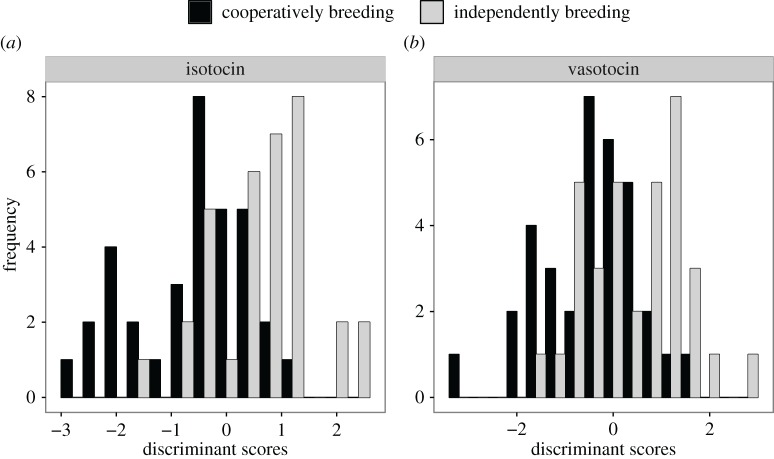
Discriminant function scores for (a) isotocin neuronal phenotypes and (b) vasotocin neuronal phenotypes. Individual fish were significantly classified into their cross-validated social system using their isotocin (p < 0.05) but not their vasotocin neuronal phenotype (p > 0.05).